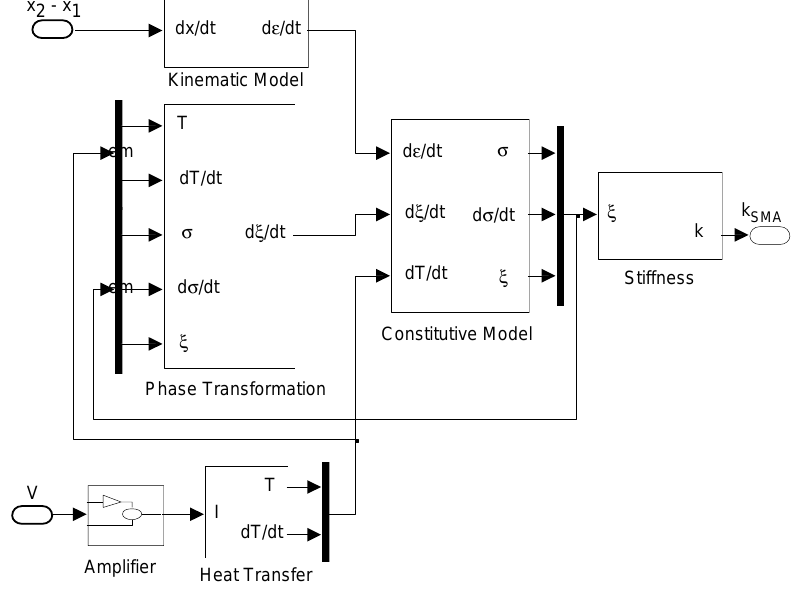
Fig. 8. Block diagram showing the SMA wire’s model.